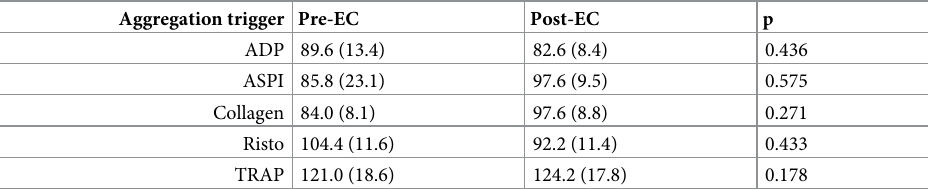
Means of the area under the curve (AUC) values of Multiplate 1 aggregation measurements (SEM) in arbitrary units. For activation of platelets, adenosine diphosphate (ADP), arachidonic acid (ASPI), collagen, Ristocetin (Risto), or thrombin receptor activating peptide (TRAP) was used. P-values of t-test were calculated for each